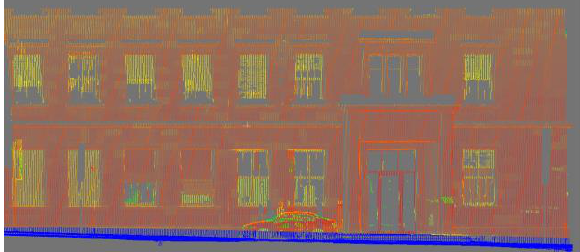
Figure 2. Cross section of a fraction of raw and pre-processed laser scanning data